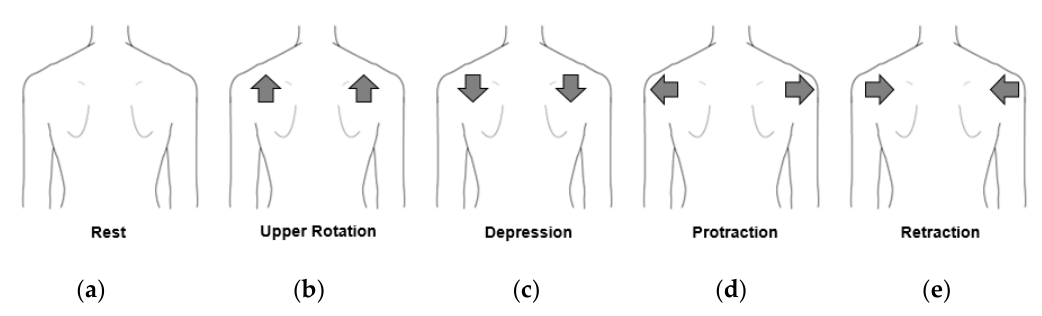
Figure 6. The five different shoulder postures used in the experiments. ( a ) Rest; ( b ) elevation; ( c ) depression; ( d ) protraction; and ( e ) retraction.